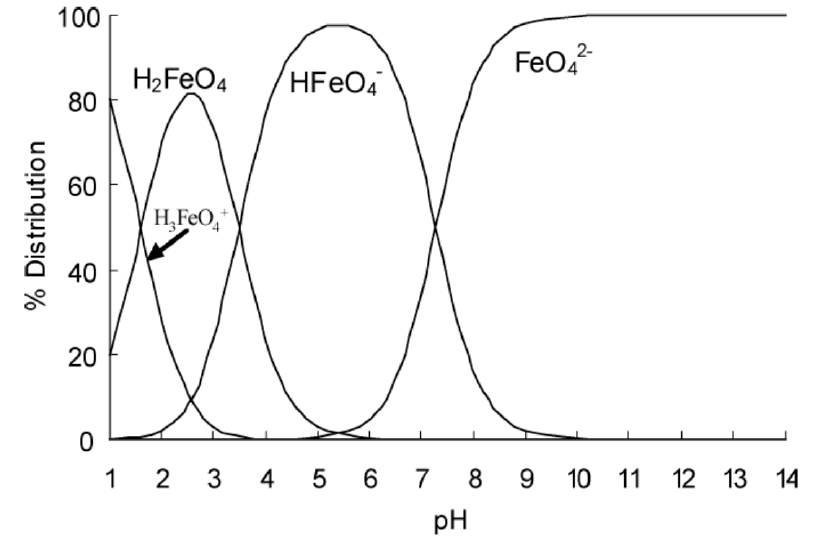
Figure 8. Distribution of protonated species of Fe(VI) as a function of pH [124].